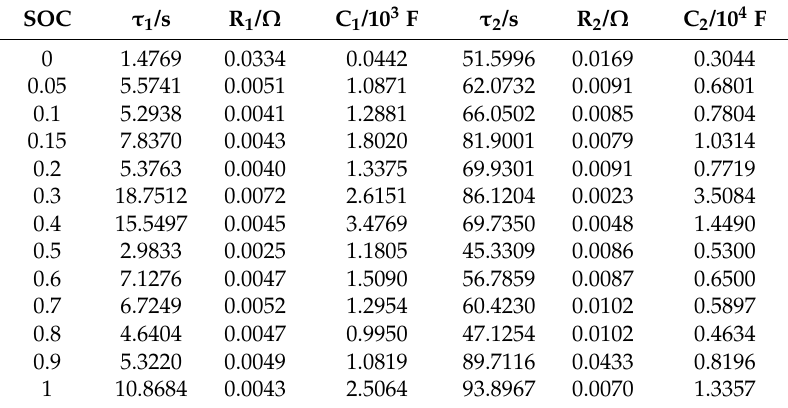
Table 3. The polarization resistance and polarization capacitance values of lithium-ion batteries for the second-order RC